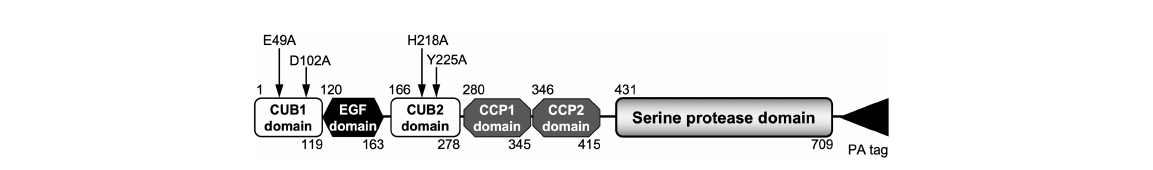
FIGURE 1 A schematic domain structure of rmMASP-3-PA. The numbers at the top and bottom represent the fi rst and last amino acid numbers in each domain, respectively according to the information in the UniProt database (UniProt ID: P98064). The arrows indicate the four different positions of the single amino acid substitutions for alanine used in the current